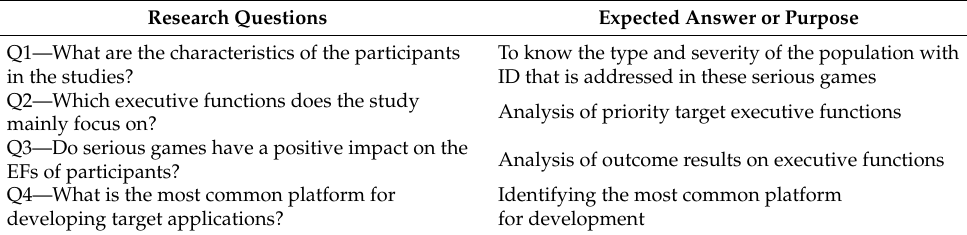
Table 1. Key research questions for the study presented.